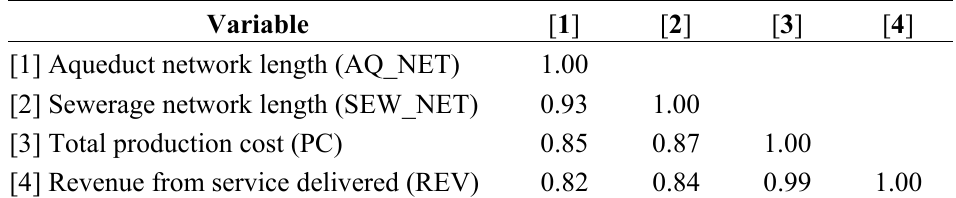
Table 2. Pearson correlations between input and output